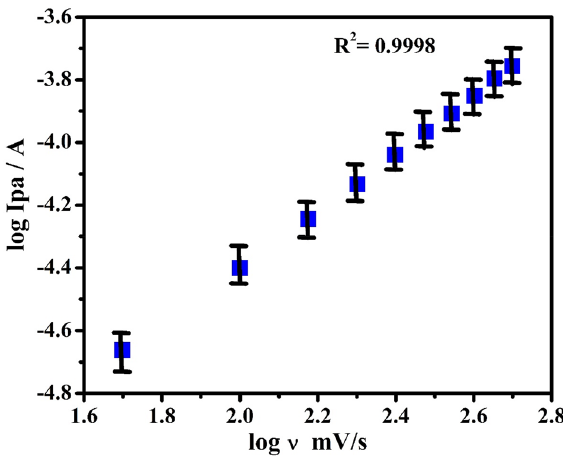
Figure 9. Graph of log Ipa vs log SR of PA (0.1 mM) in PBS (0.2 M, pH 7.4).